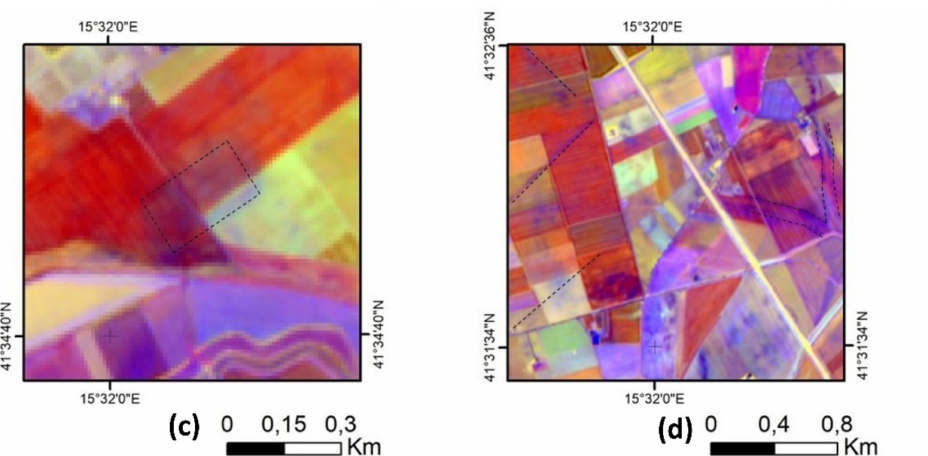
Figure 13. Some examples of features of archaeological interest identified in the study area: ( a ) circular or sub-circular shapes of Neolithic settlements; ( b ) geometrical shapes organized in regular complexes of the Classical period (Arpi); ( c ) Rectangular farmhouses of the medieval period (Torretta di Sezze); ( d ) paleochannels, roads, and traces of centuriation of di ff erent